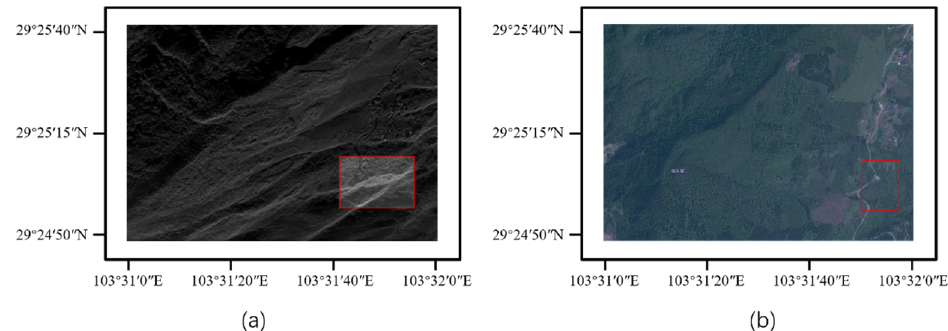
Figure 10. The actual data of the Shawan district: ( a ) is the SAR image; ( b ) is the optical image. The red box circles the area of our experiment.